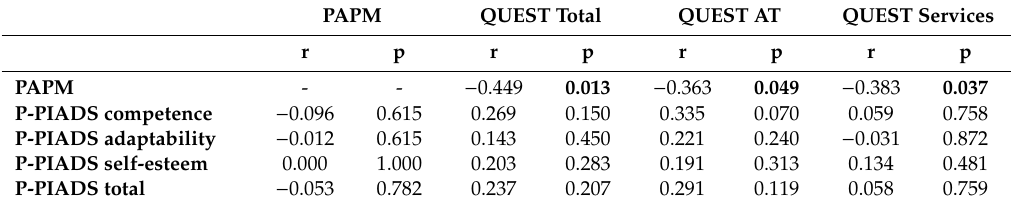
Table 3. Relation between PAPM, P-PIADS and QUEST scores (n = 30). PAPM QUEST Total QUEST AT QUEST Services